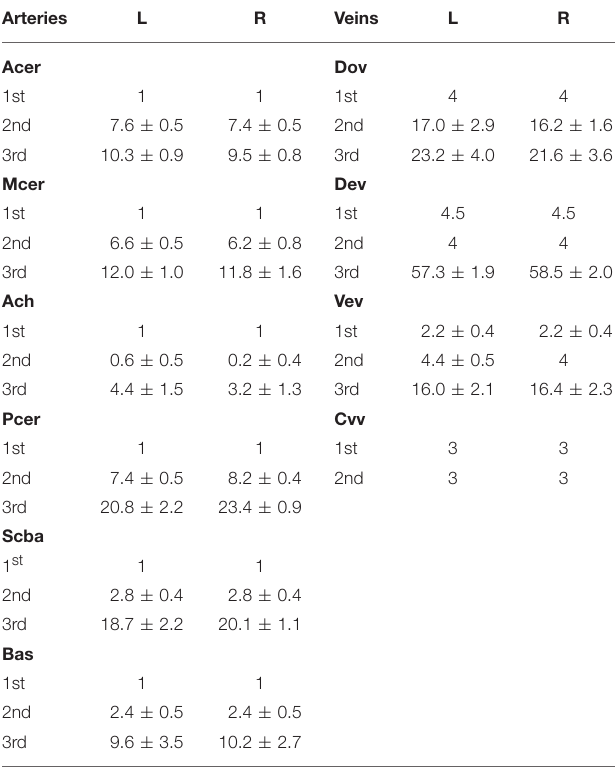
TABLE 1 | Statistical table of the branch numbers of arteries and veins at 3 levels. Arteries L R